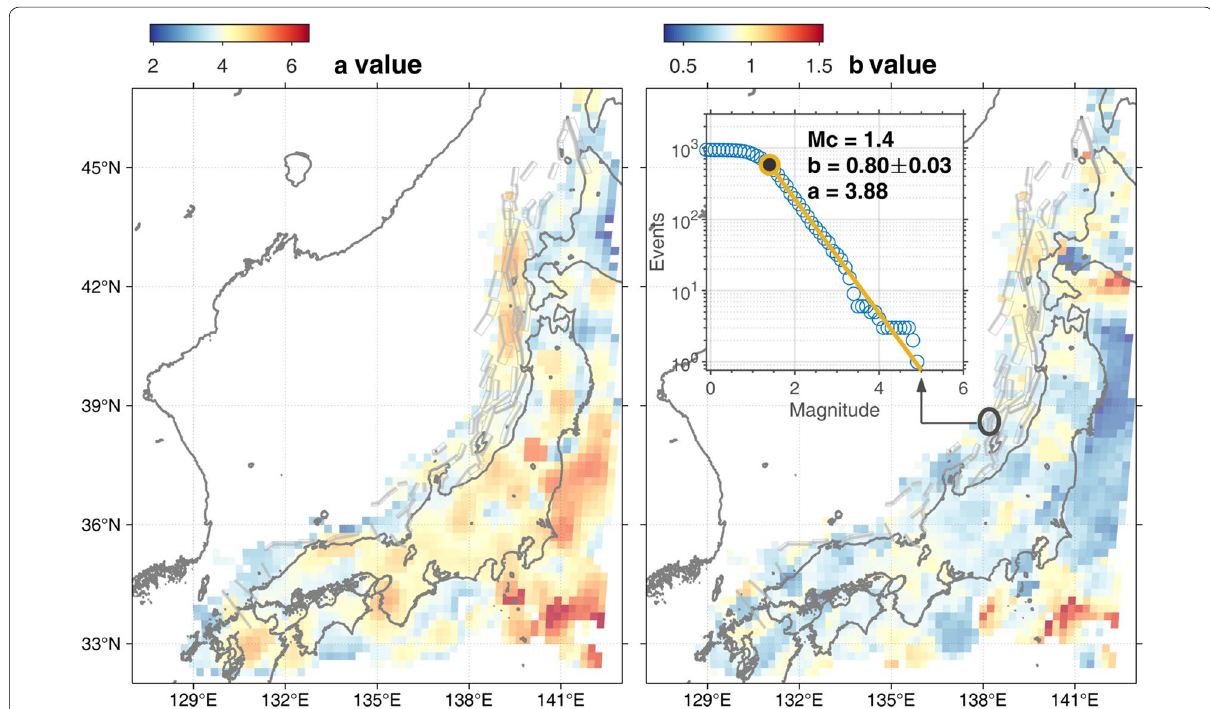
Fig. 6 Maps of a and b values determined from the JMA unified hypocenter catalog over a period of 1997–2017. Inset in the right panel shows the fit between observed seismicity and the Gutenberg–Richter frequency magnitude distribution within the specified sampling radius (black circle). Faults are drawn in light gray with bold lines mark the top edge of